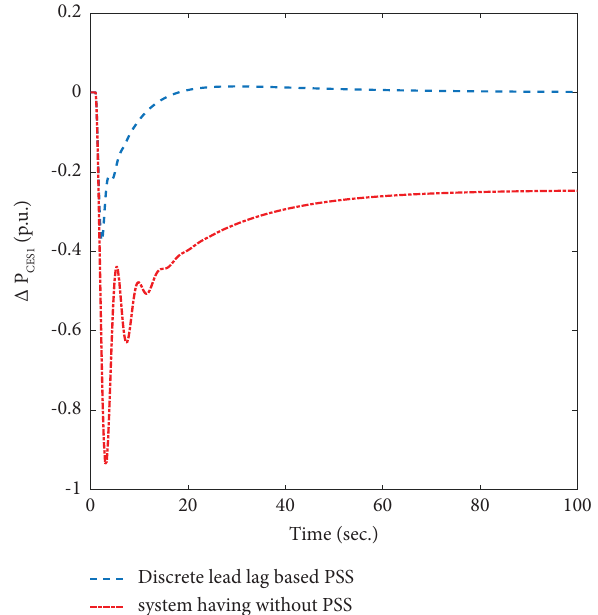
Figure 3: Power deviation in capacitive energy storage of area-1 Δ P CES1 (p.u.) with respect to time (sec) for without having any PSS and with the discrete lead-lag-based PSS.